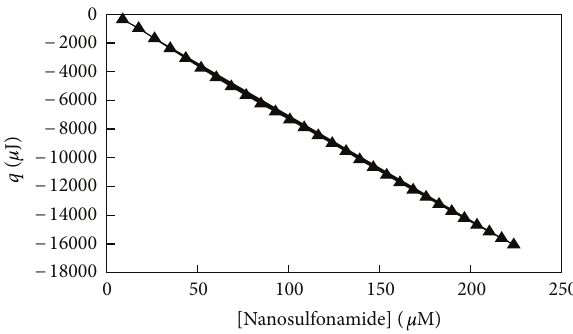
F 1: Comparison between the experimental heats ( for (nanosulfonamide + HSA) interactions and the calculated data (lines) via